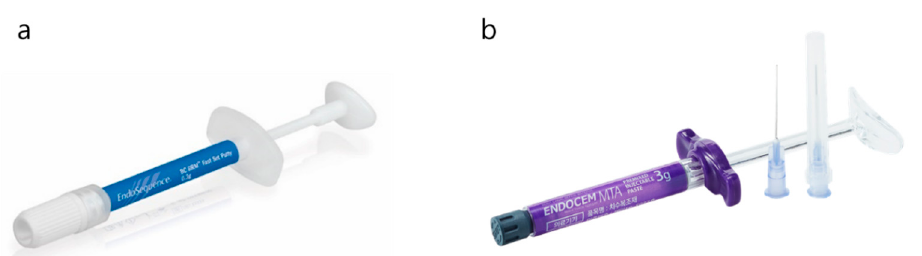
Figure 20. Commercially available premixed calcium silicate root-end filling materials. ( a ) Endo-sequence Root Repair Material (RRM). (Image courtesy of Brasseler, https://brasselerusadental.com/products/bc-rrm-fast-set-putty/, accessed on 28 January 2021) ( b ) Endocem MTA Premix (Image courtesy of